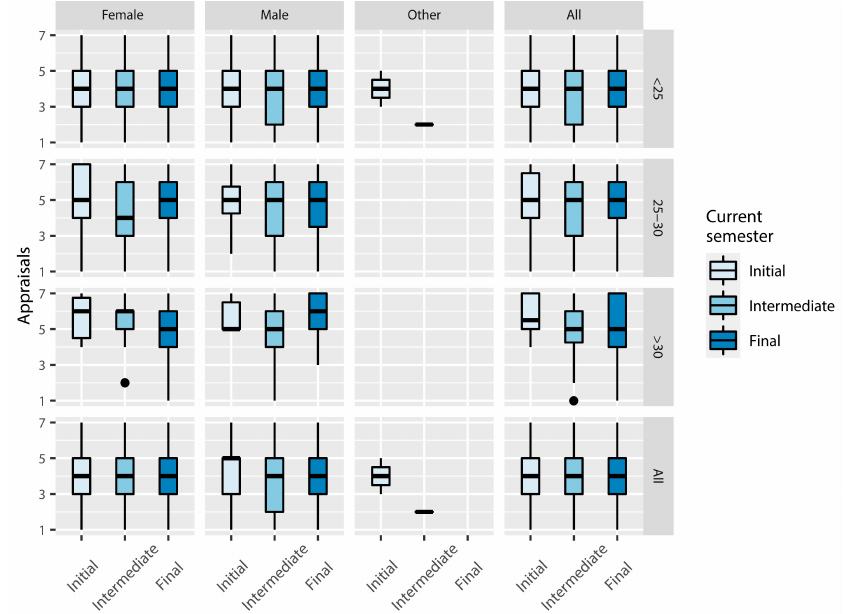
Figure 3. Box plot of the students’ satisfaction with the online learning method, split by ‘gender’ (‘Male’, ‘Female’, ‘Other’, and ‘All’), ‘age’ (‘<25’, ’25–30’, ‘>30’, and ‘All’), and ‘current semester’ (semester in which the survey was conducted).